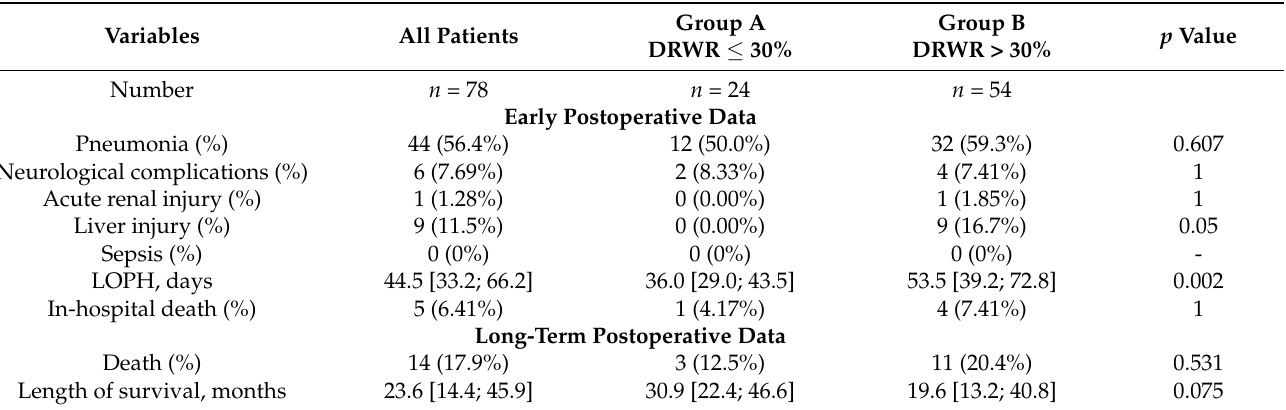
Table 2. Outcomes after heart transplantation.